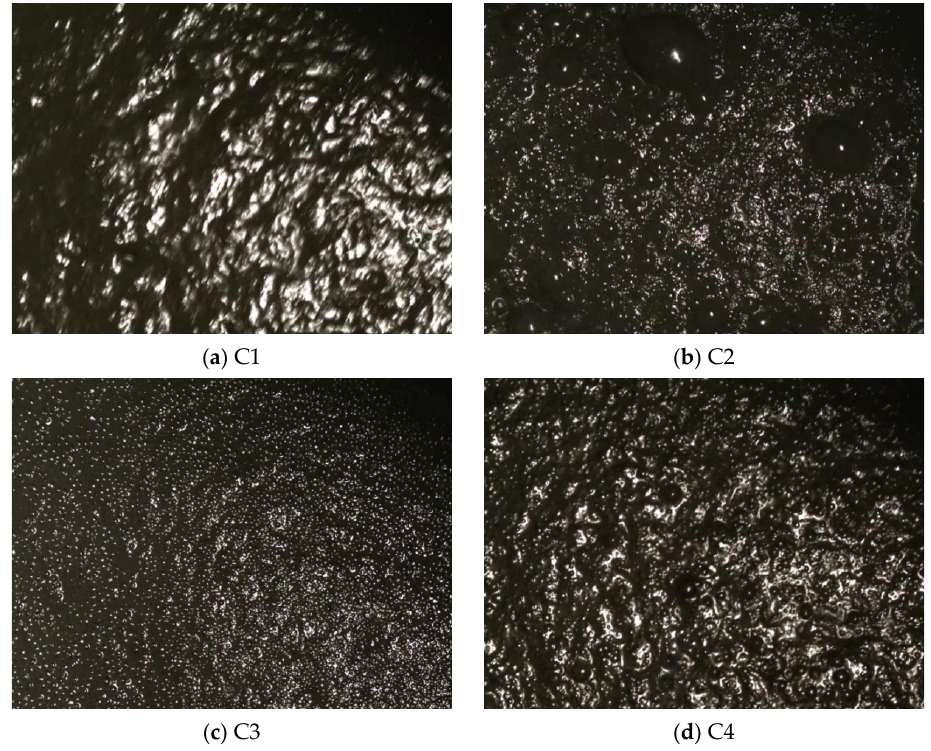
Figure 12. Image of froth under four different typical working conditions.